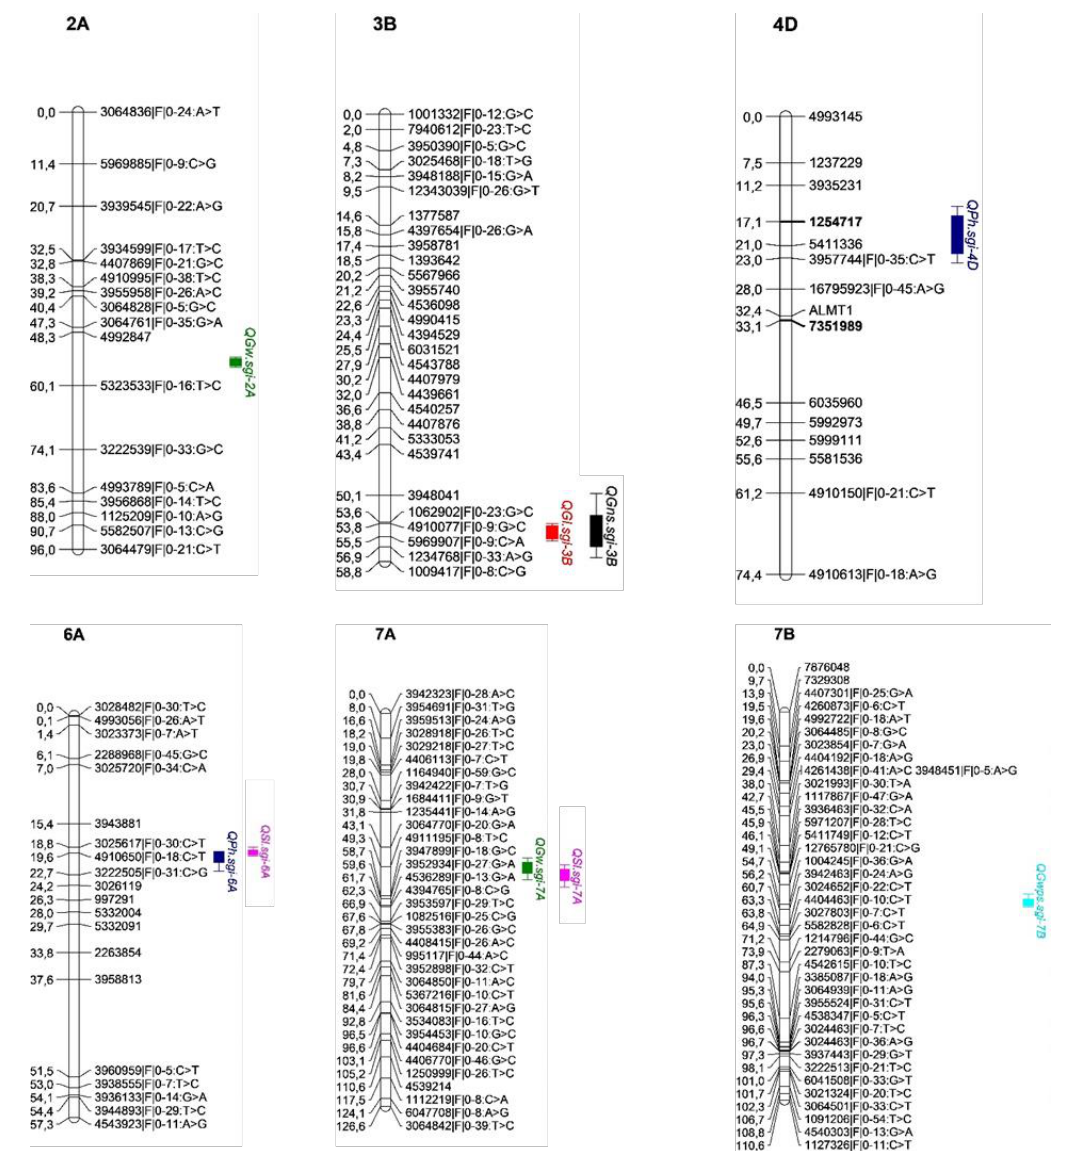
Figure 2. The chromosome regions harbouring QTL for plant height (PH), spike length (SL), grain number per spike (GNS), grain weight per spike (GWPS), grain length (GL), and grain width (GW). Vertical bars represent the confidence interval and LOD peak position of each QTL identified using the linkage map of Tugela-DN x Elands DH population. Table 3. QTL detected in two (2) or more environments and/or combined QTL analysis in the Tugela-DN × Elands doubled haploid population for plant height and yield component traits. Chromosome Marker Interval/Flank- Trait a QTL c (Position) b ing Marker